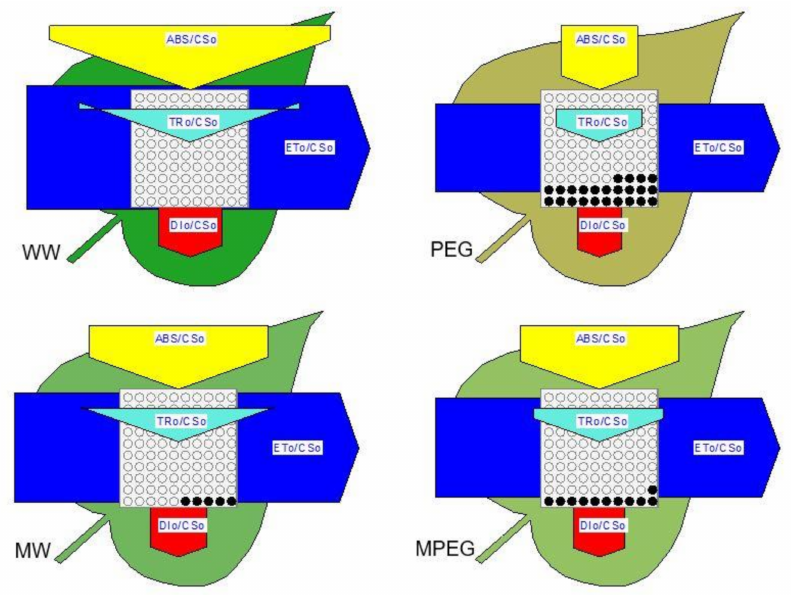
Figure 8. Energy pipeline leaf model of phenomenological fluxes (per cross-section, CSo) in WW, MW, PEG, and MPEG plants under normal and PEG-induced osmotic stress conditions. The details of each parameter are given in Supplementary Table